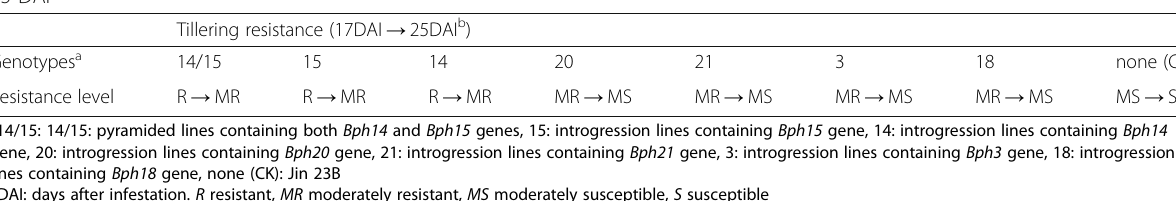
Table 1 The tillering resistance of different genotype of Bph3 , Bph14 , Bph15 , Bph18 , Bph20 and Bph21 conferring to BPH 17 DAI and 25 DAI